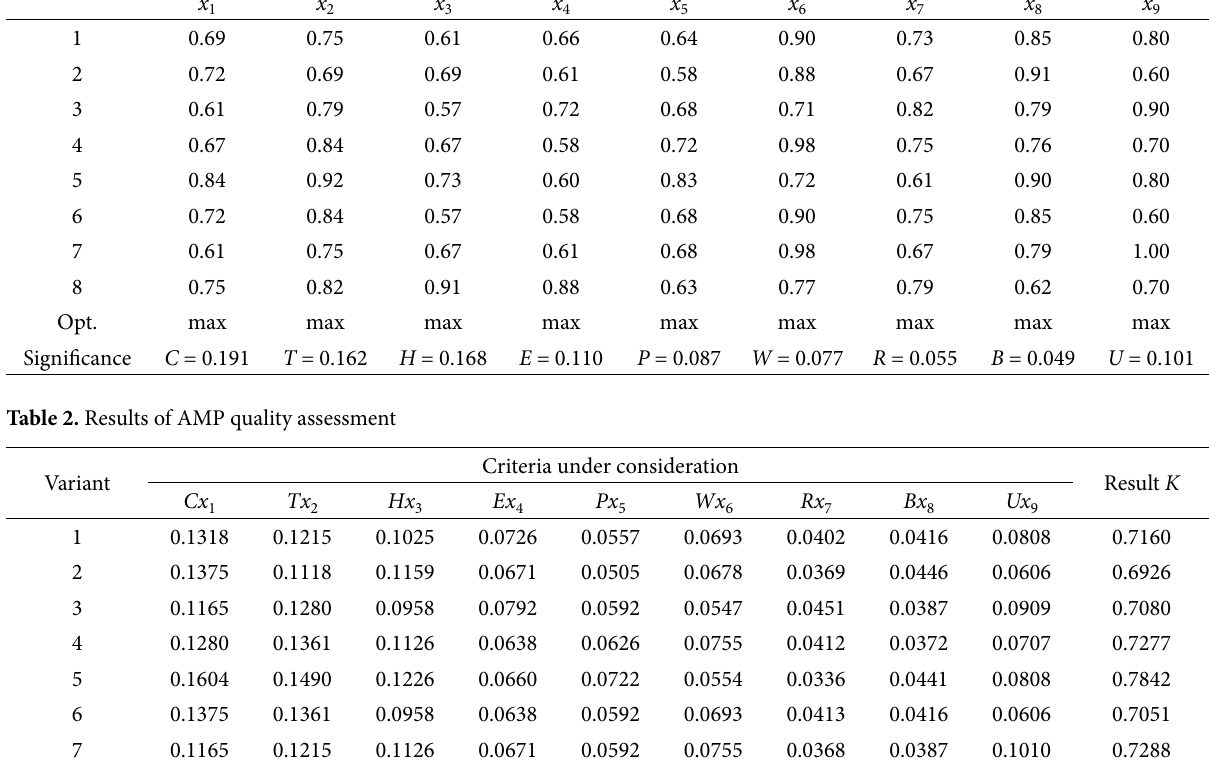
Table 1. Decision-making matrix for quality assessment of AMP Variant